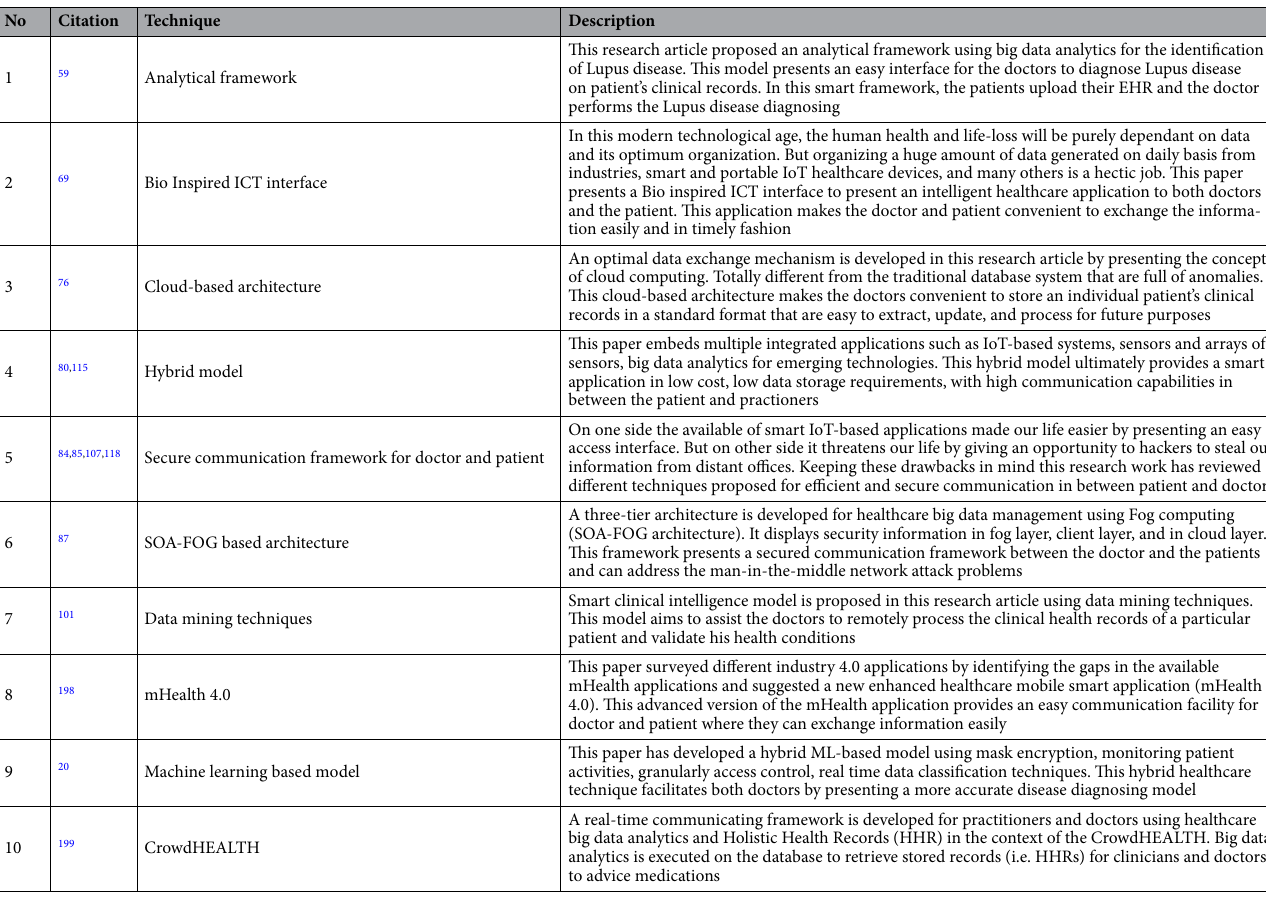
Table 9. List of techniques proposed for efficient communication and information